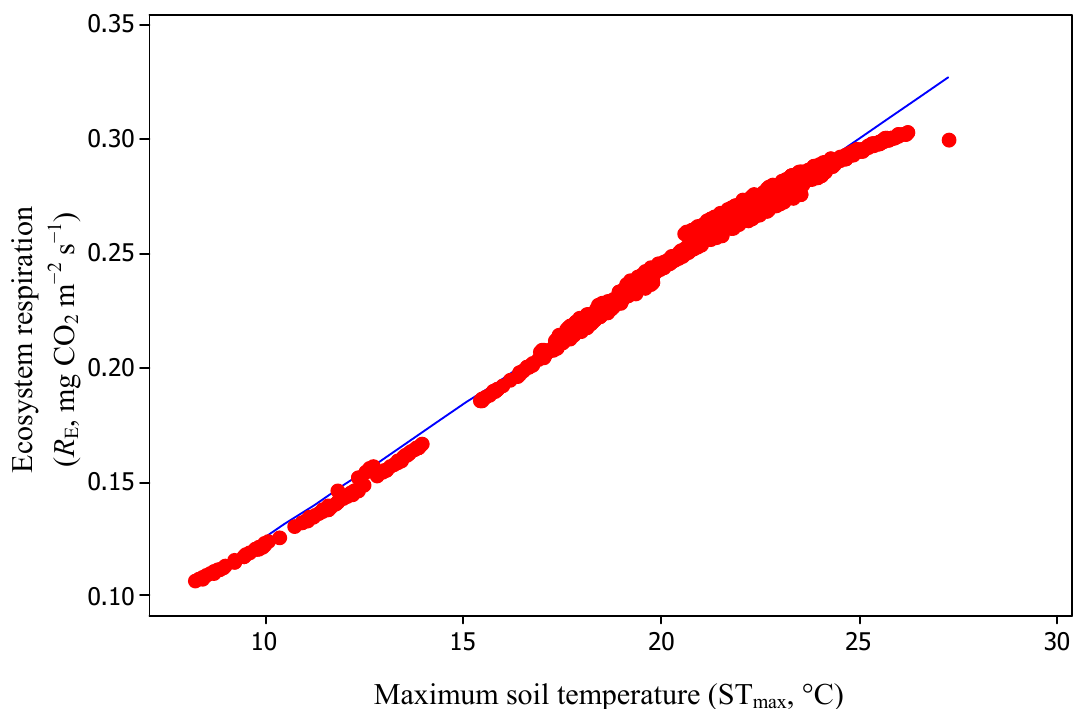
versus daytime R based on Equation (11) for the max E = 99.3%; SE = 0.0039; n = 896; P < adj